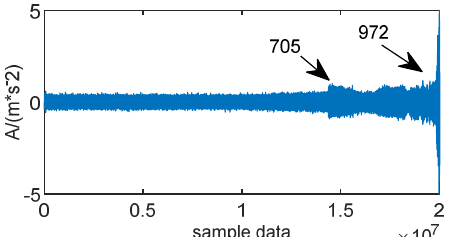
Figure 12. Time-domain waveforms of bearing 1 outer ring failure data for the full-life cycle.